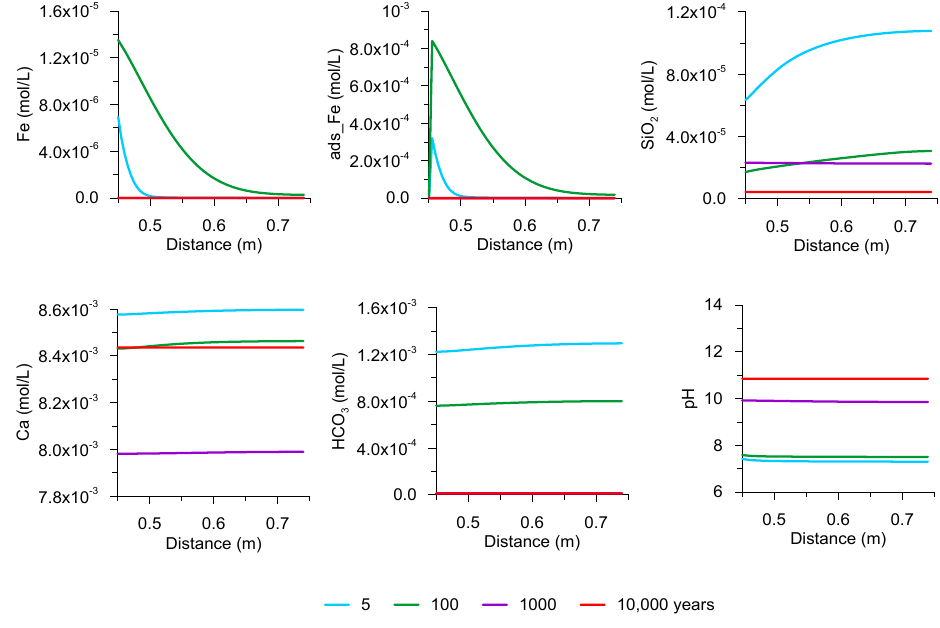
Figure 2. Concentration of dissolved species in the porewater and of adsorbed species against distance for the reference model (r c = 2 µ m y − 1 ). The interface between steel and bentonite is at 0.45 m. Results after 5, 100, 1000 and 10,000 years of interaction are